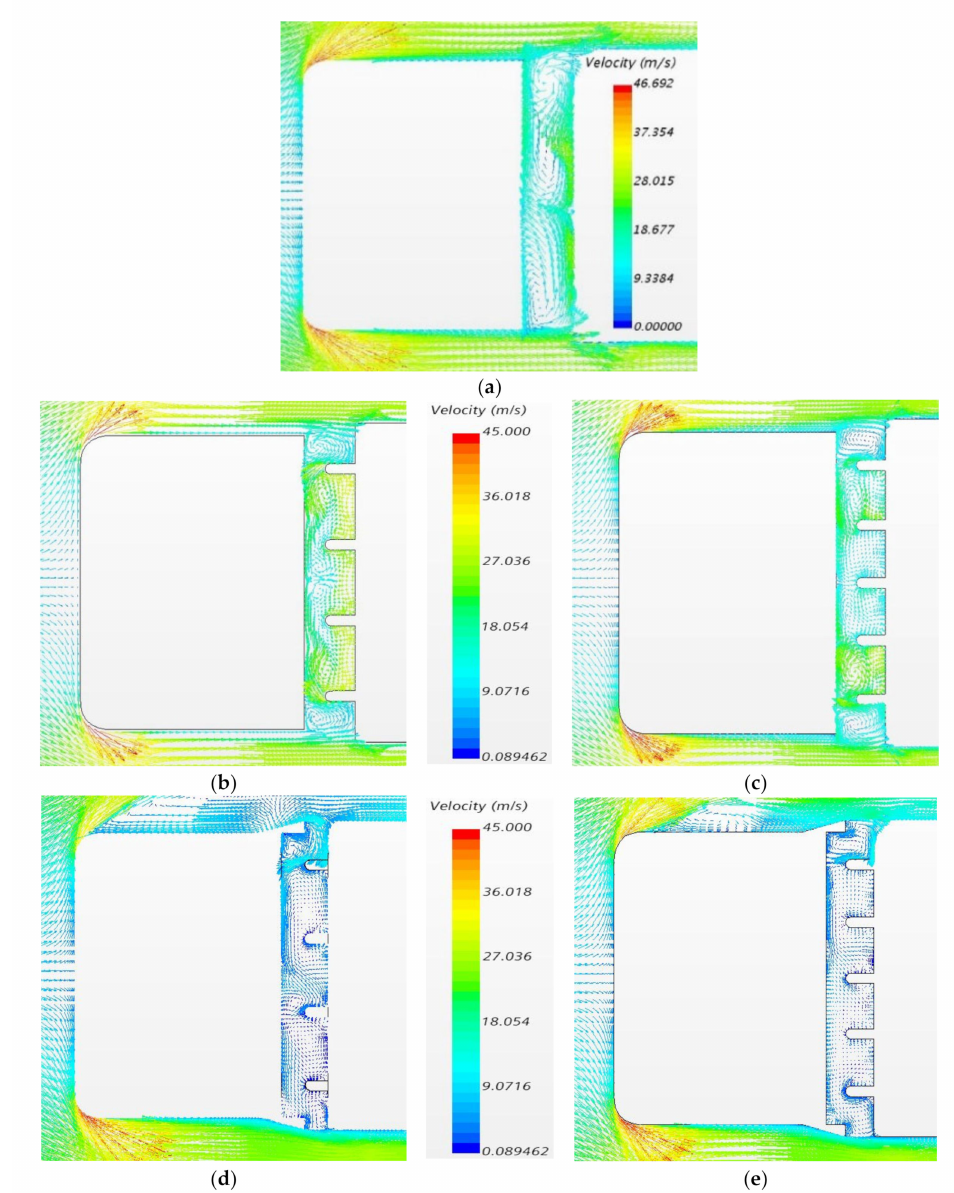
Figure 8. Velocity vectors on the XZ plane at y = 0.2 m: ( a ) baseline case; ( b ) Case 1; ( c ) Case 2; ( d ) Case 3; ( e ) Case